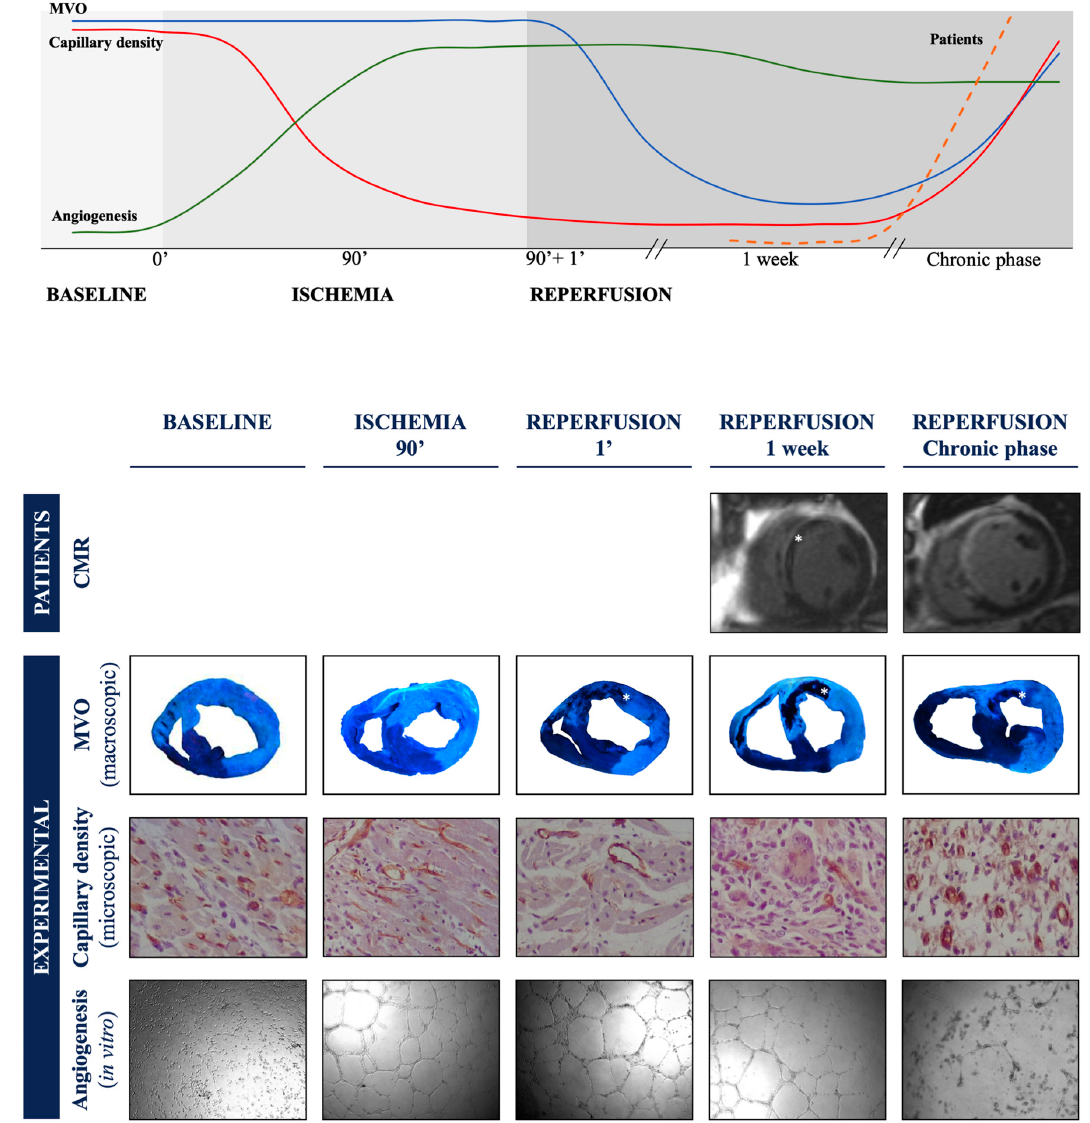
Figure 6. Dynamics of occurrence and repair of microvascular obstruction (MVO). Asterisks point to areas with MVO (adapted from [10]).